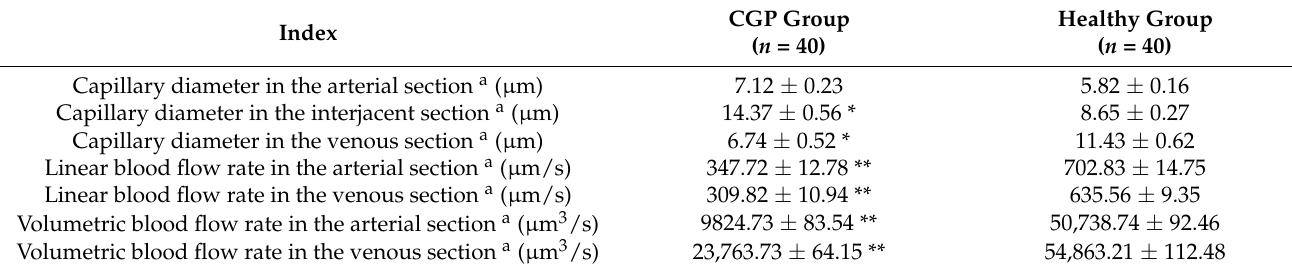
Table 2. Microcirculation indices in the transitory fold of the oral cavity in patients with chronic generalized